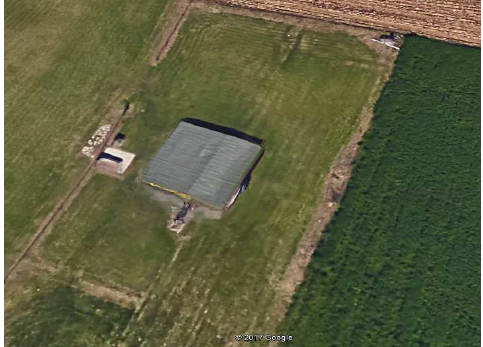
Figure 4. The flight field chosen as test area.